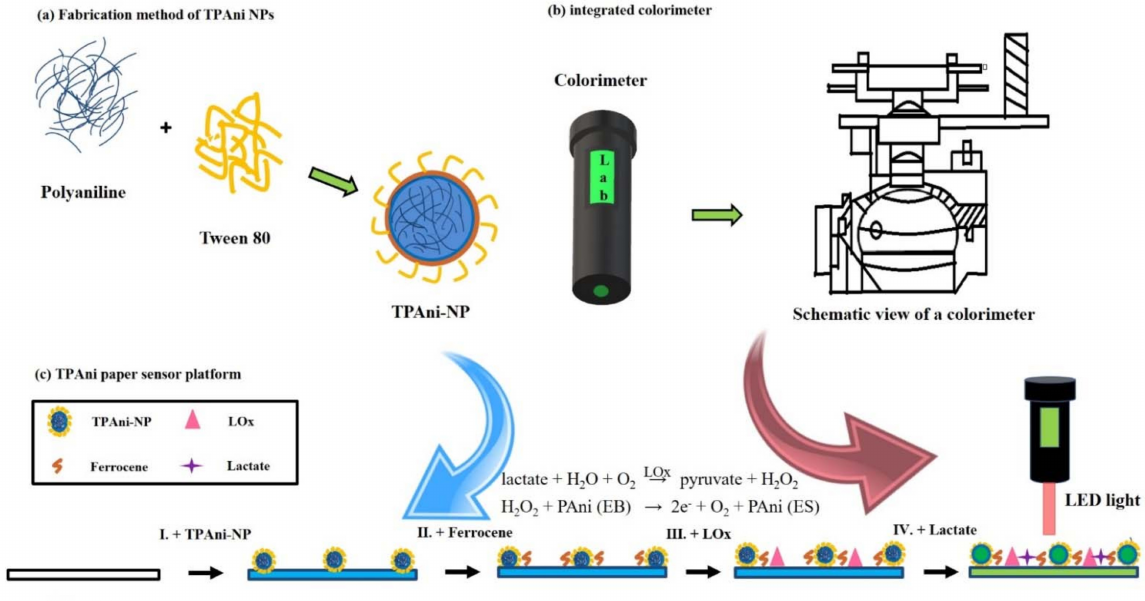
Figure 1. Schematic of: ( a ) synthetic process of the TPAni nanoparticles (TPAni-NPs), ( b ) de- scription of the colorimeter, and ( c ) lactate sensing mechanism of the TPAni-NP-adsorbed paper sensor